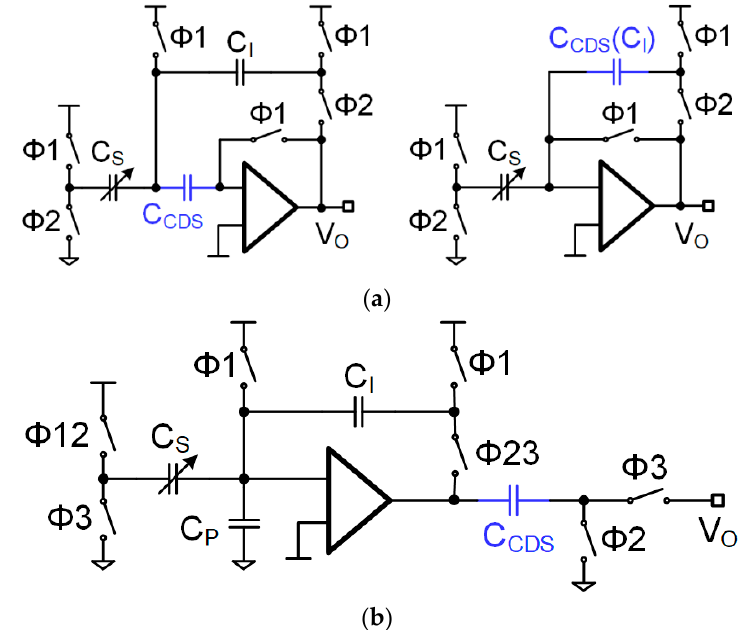
Figure 9. Summary of the CDS technique. ( a ) Type-I (left) and Type-II (right). ( b ) Type-III.